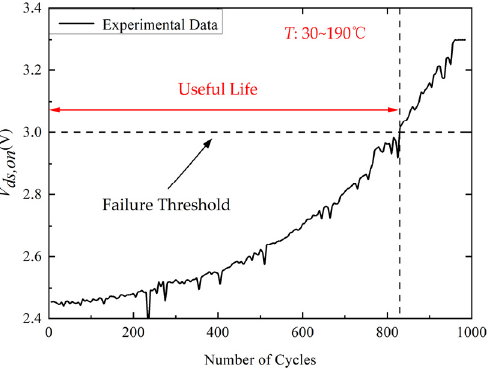
Figure 7. The experimental data of V ds,on ( Δ T = 160 °C). Table 3. Comparison of different failure precursors.